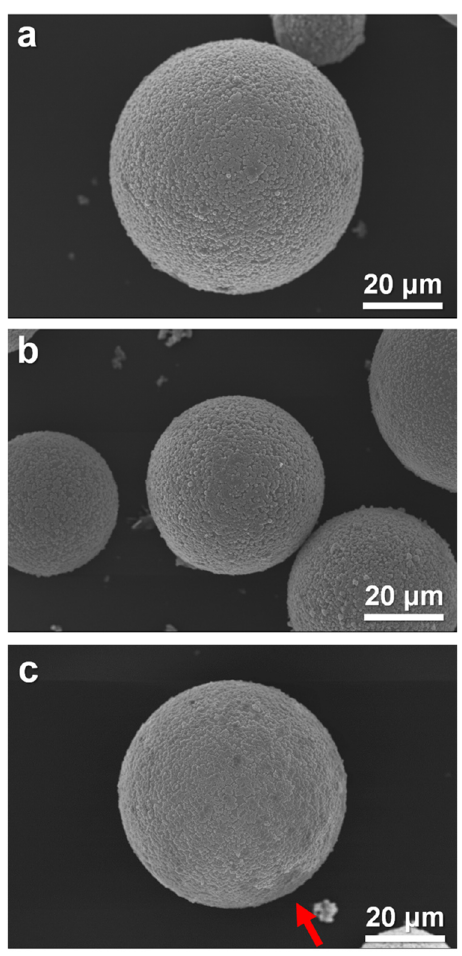
Figure 5. SEM images of ( a ) HGM-RC-400; ( b ) HGM-RC-600; ( c )